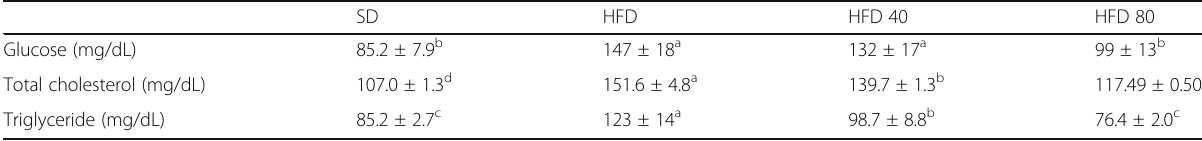
Table 2 Effects of purpurin on plasma lipid profiles in high-fat fed mice